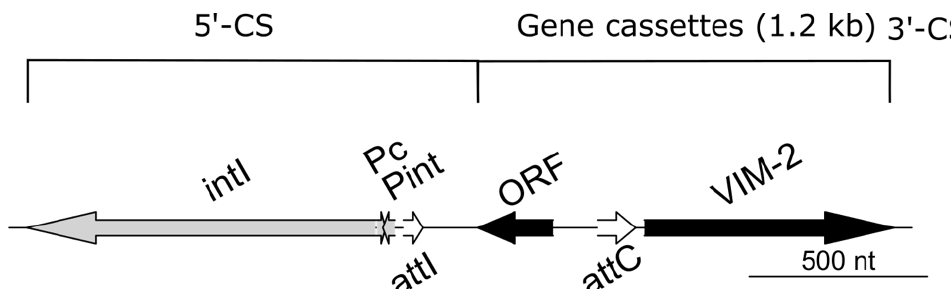
Figure 2. Illustration of the class I integron (2518 bp) of the outbreak strain. Abbreviations: intl — class integrase gene; P c and P int — gene cassette promotors; attI — integron-associated recombination site; ORF—open reading frame; attC— recombination site of the gene cassette; VIM-2—Verona integron- borne